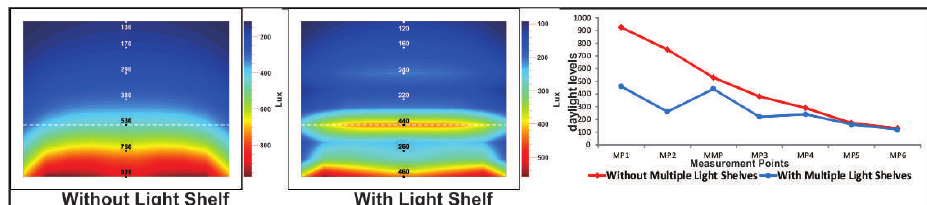
Fig. 14. Comparison of light distribution at 5 p.m.